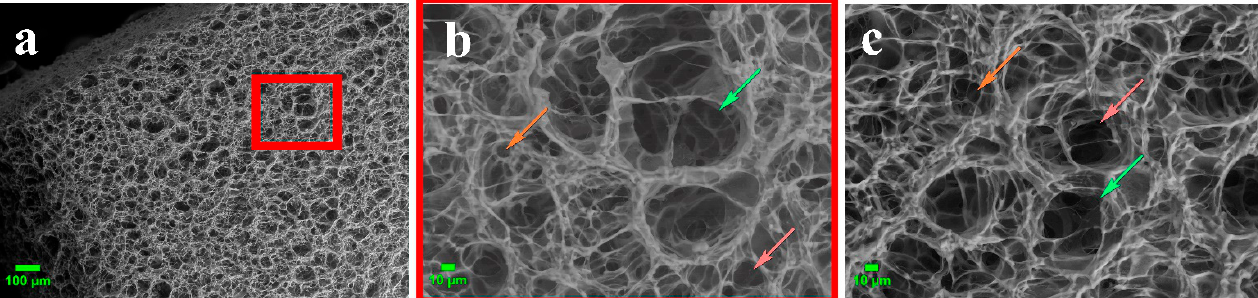
Figure 3. Morphological characterization of the EDC ‐ tanned gelatin cryostructurate with environmental SEM (see Section 4.4): ( a ) the image at low magnification (scale bar = 100 μ m); ( b ) the image of the upper surface (scale bar = 10 μ m); ( c ) the image of the bottom surface (scale bar = 10 μ m). Green arrows—large pores; orange arrows—small pores.